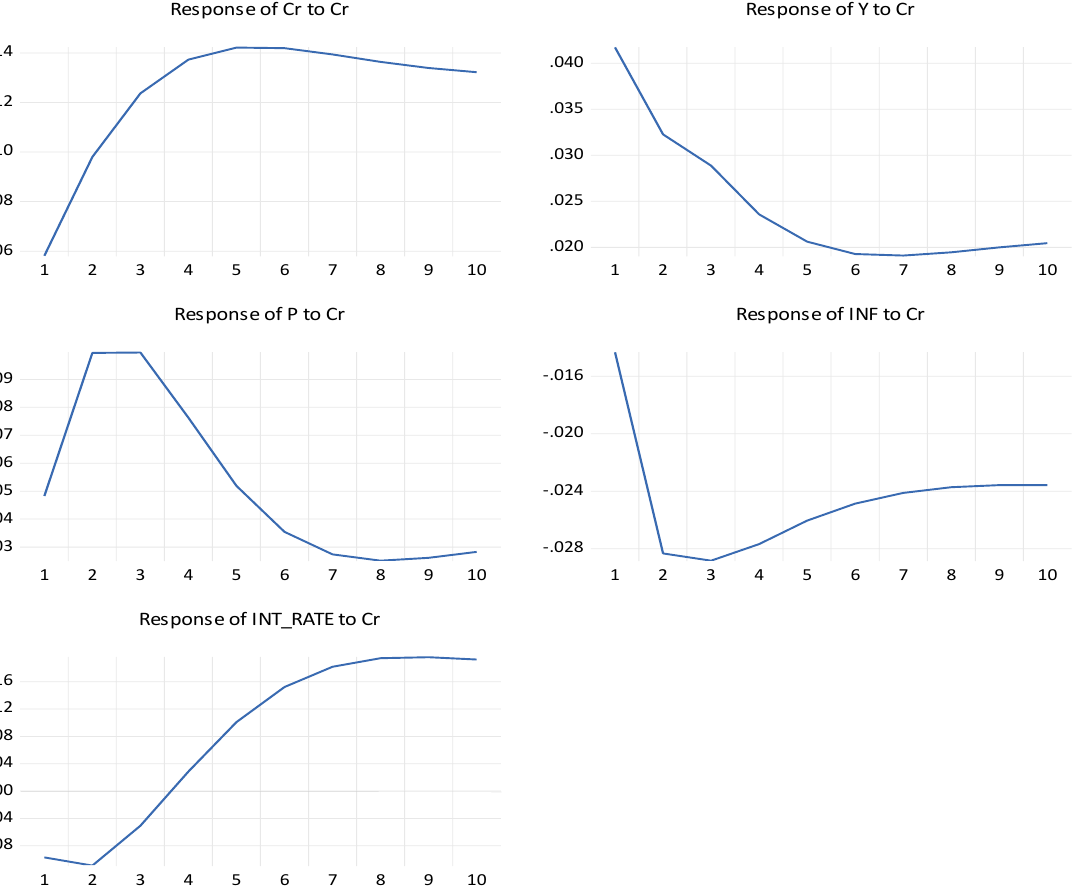
Figure 1. Mortgage credit volume response to housing demand in Ankara, Turkey.